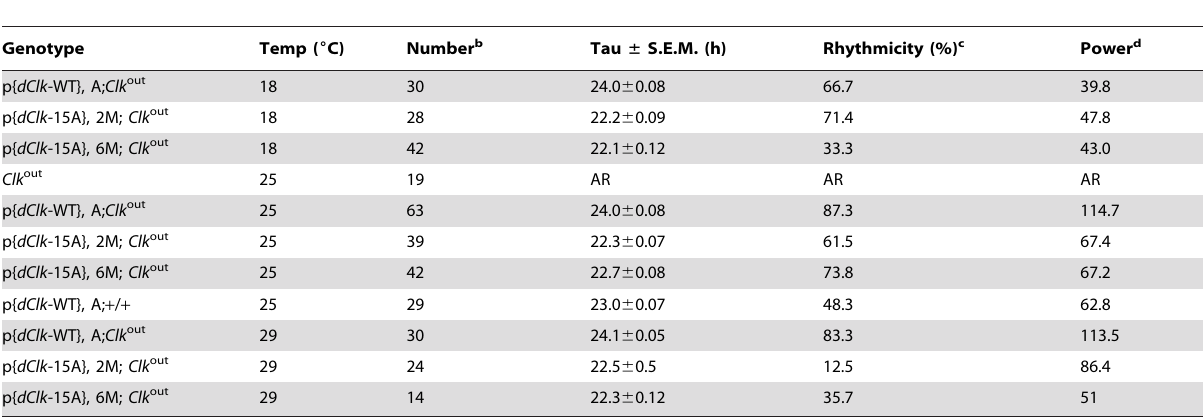
Table 2. Behavioral analysis of p{ dClk -15A}; Clk out flies following light/dark entrainment. a